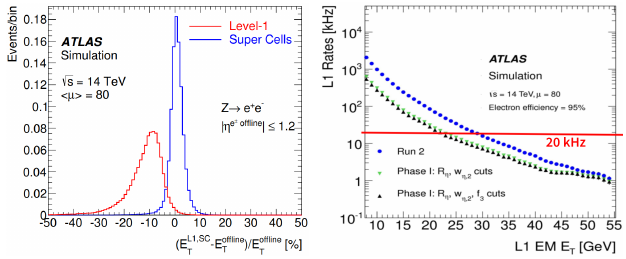
Figure 4: Expected performance of the Phase-I trigger upgrade [7]. In the plot on the left, the percent difference between the E T of elec- trons reconstructed offline ( E offline T ) and using the Run-2 L1 is shown in red, while the difference between this offline reconstruction and the energy from SCs is shown in blue, where the E T has been simulated using Z → e + e − events in the EMB calorimeter. The plot on the right shows expected L1 trigger rates for L = 3 × 10 34 cm -2 s -1 as a function of the EM E T threshold for the case of the Run-2 trigger (blue) and the Phase-I trigger scheme with different selections of shower shape vari- ables (black and green). A red line indicates the L1 limit of 20 kHz for electromagnetic objects, which will remain in